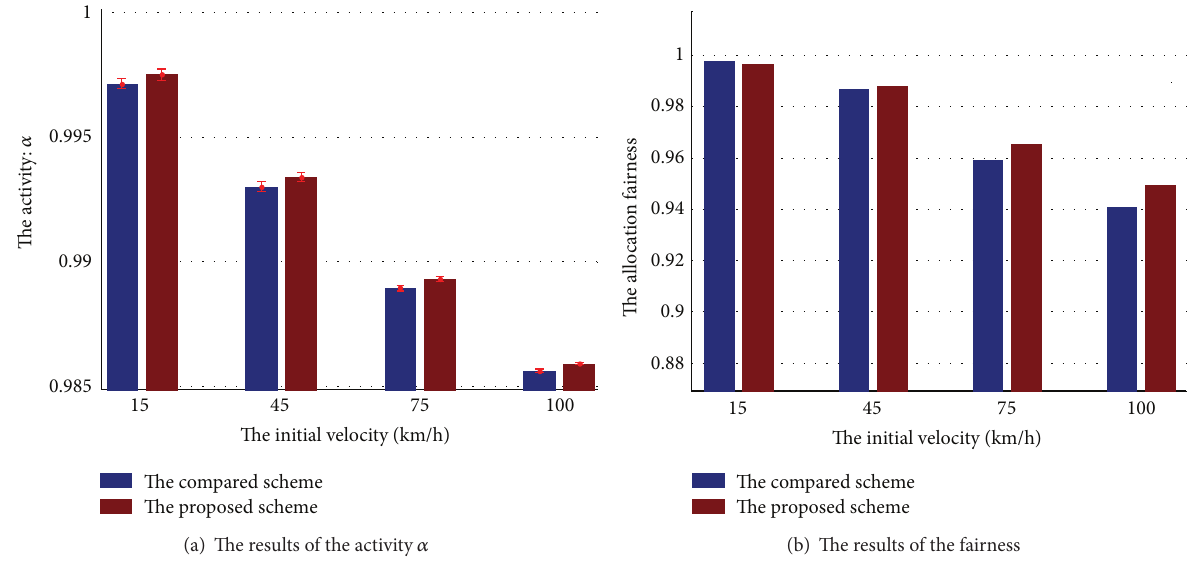
Figure 8: The simulation results under different initial